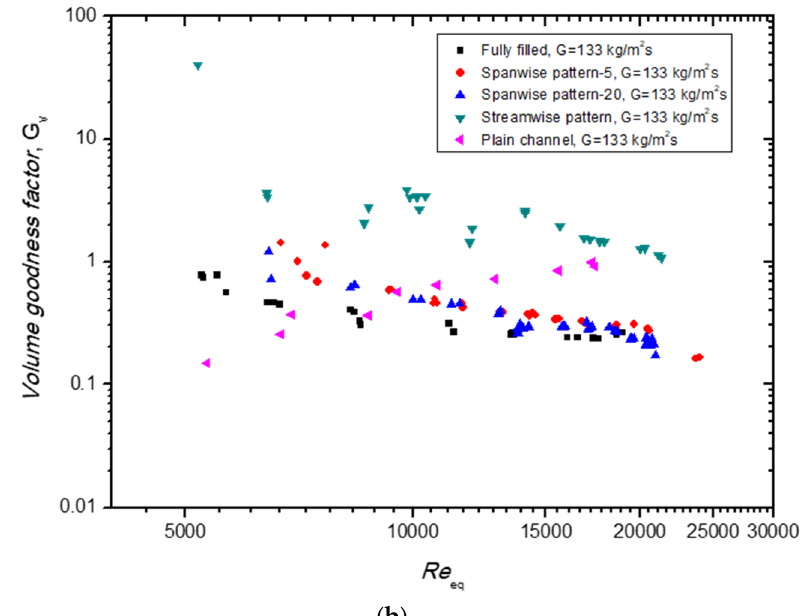
Figure 10. Comparison of ( a ) flow area’s goodness factor and ( b ) volume’s goodness factor of different patterned models of porous media with the fully filled porous media channel and plain channel at G = 133 kg/m 2 s.